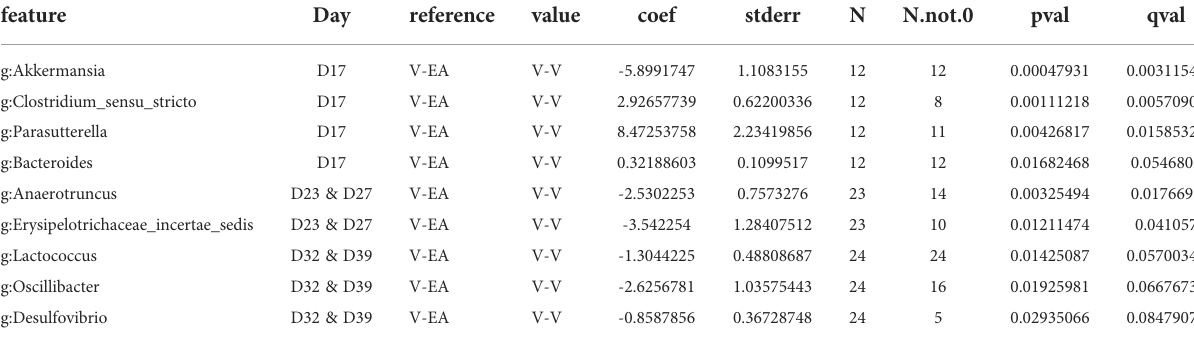
TABLE 2 Taxa that differed as an effect of A. muciniphila -enriched FMT, between V-V and V-E A recipient female mice on different days during and after completion of the FMT.